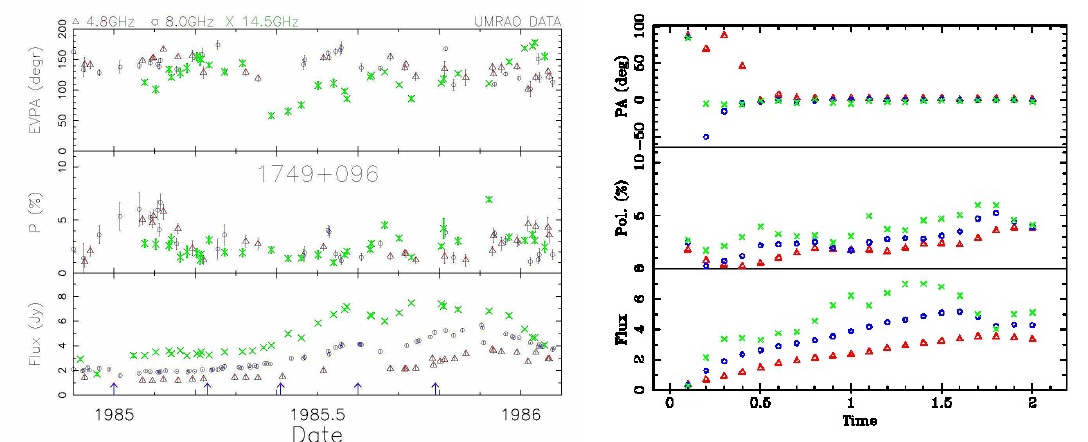
Figure 3. ( Left ): The observed light curves during T1985 showing the UMRAO data at three frequencies during a series of outbursts in total flux density. The individual flares in the total flux light curve are blended, and they do not show the triangular shape noted for 0716+714. Upwards arrows along the abscissa mark the times of shock onset; ( Right ): The simulated light curves using the adopted